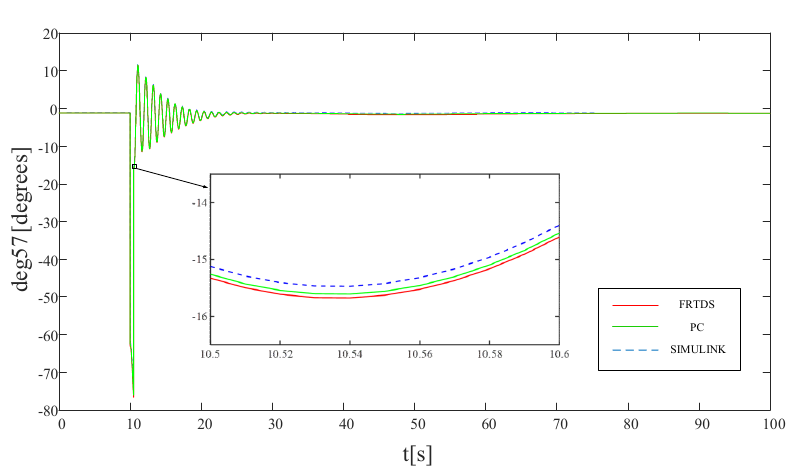
Figure 7. The voltage amplitude of bus 57.